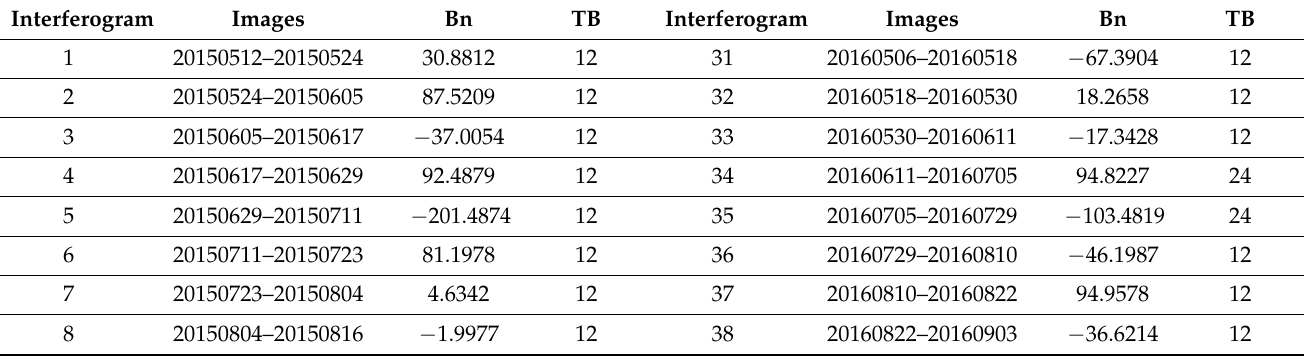
Figure 9. Relation between the displacements observed in the interferograms ( a ) and time series of displacement ( b ). The red windows highlight the high deformations observed during the two periods March–July 2016 and January–May 2017. Inter- ferograms are organized from the oldest (number 1) to the newest (number 59). Image number 60 represents the amplitude map of the analysed area, where the red dashed line shows the location of the May 20 landslide (from [39], modified). Table 1. List of images used to generate the interferograms. The dates are presented in the following format: yyyymmdd. Bn is the normal baseline (in metres). TB is temporal